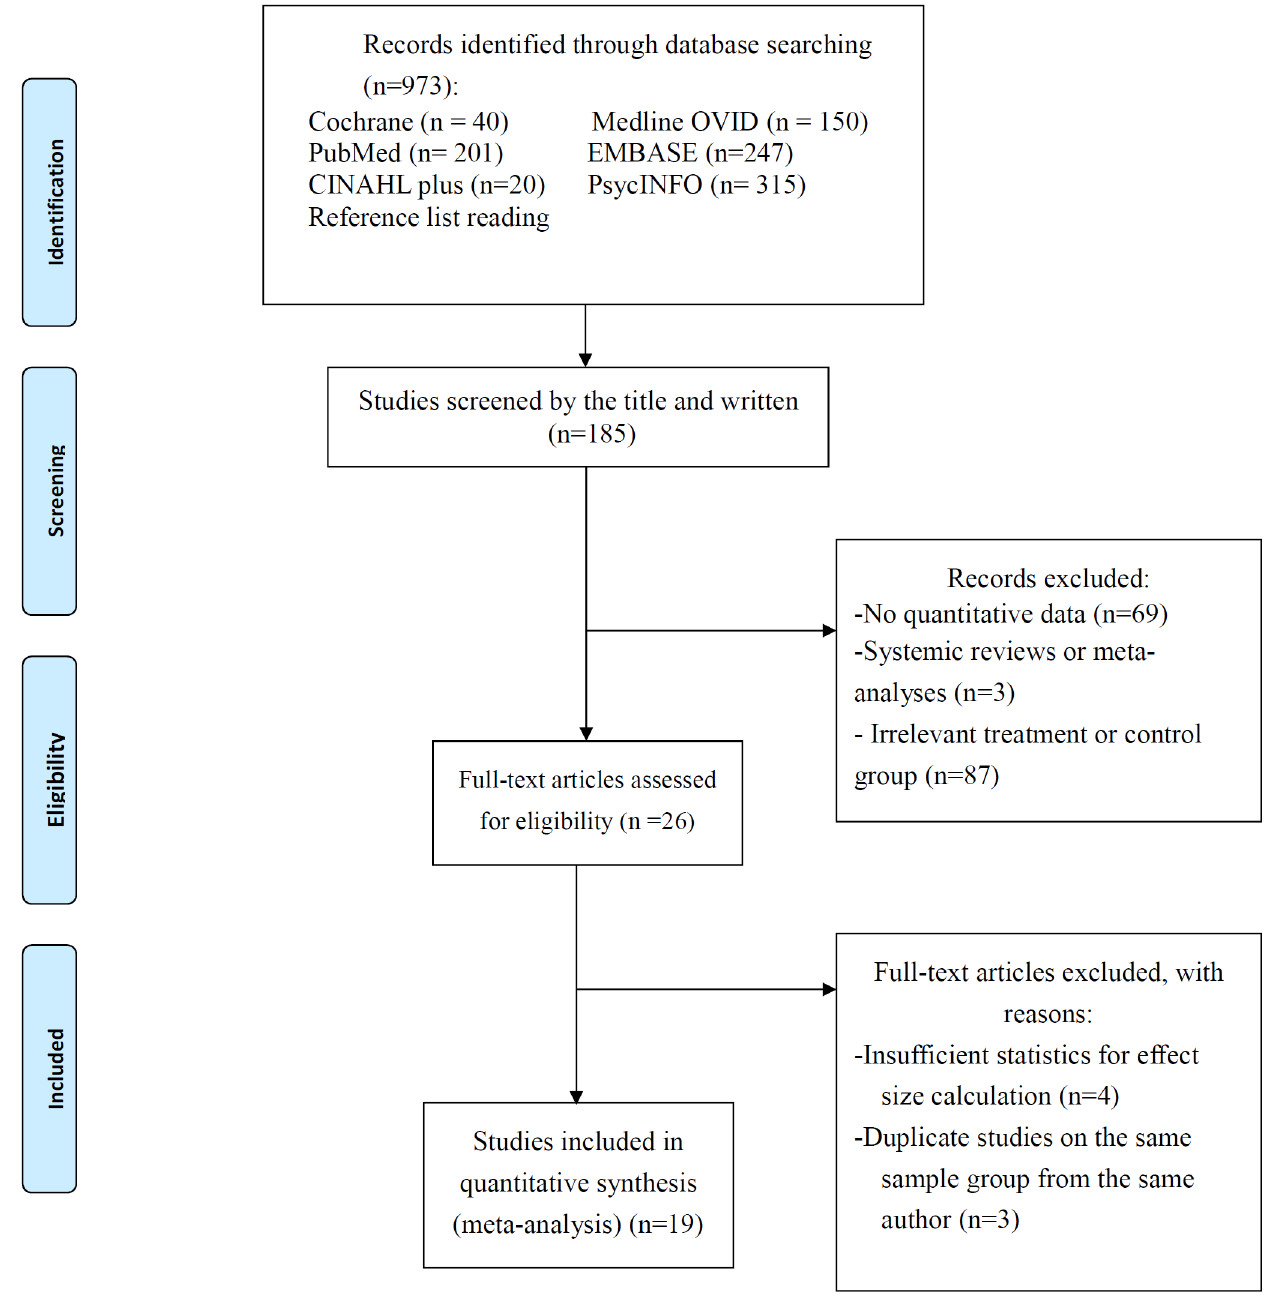
Fig 1. PRISMA 2009 flow